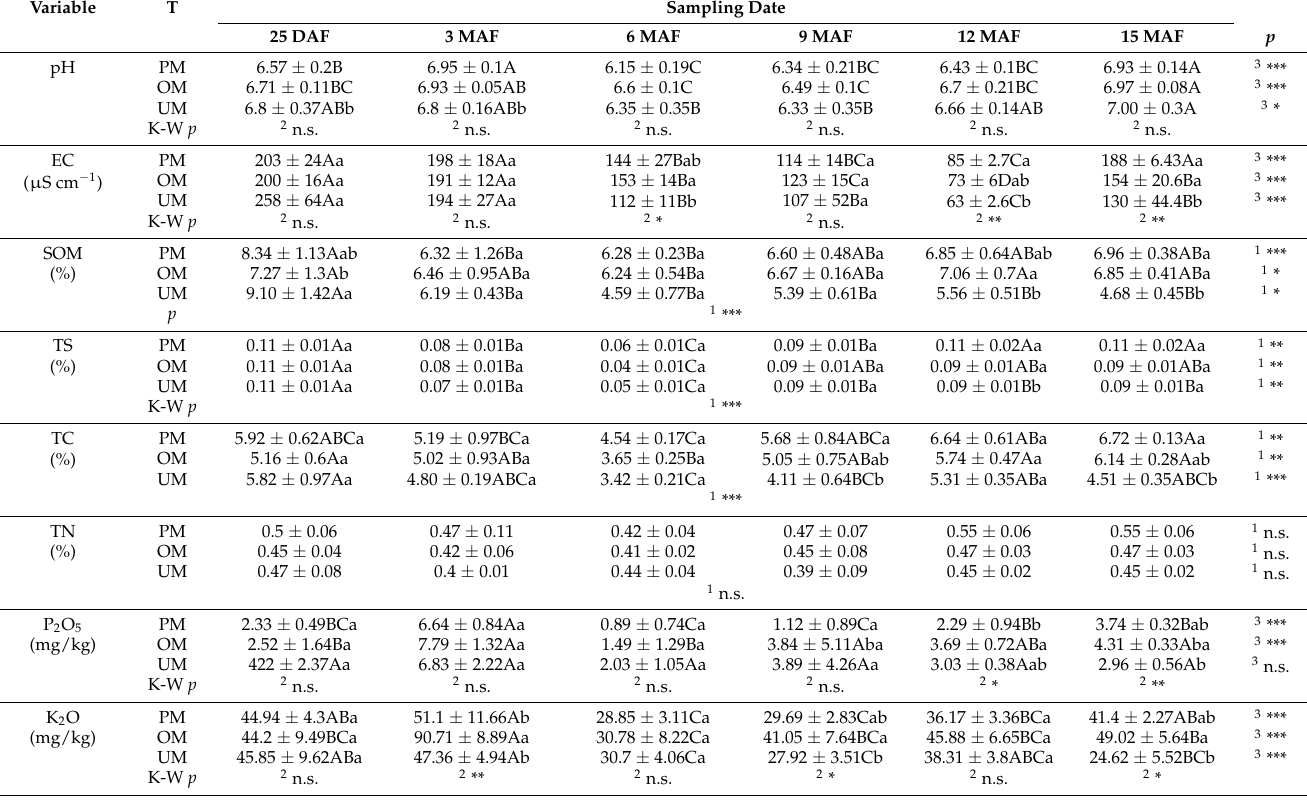
Table 4. Soil pH, electrical conductivity (EC), soil organic matter (SOM), total sulphur (TS), total nitrogen (TN), total carbon (TC), and concentrations of P 2 O 5 and K 2 O in the pine mulch (PM), olive mulch (OM), and unmulched (UM) treatments (T) during the studied period (T, treatments; DAF, days after fire; MAF, months after fire) (mean ± standard deviation). Different letters indicate significant differences between sampling dates (capital letters) and treatment (lowercase letters). 1 Two-way ANOVAs are shown for each treatment–sampling date comparison. 2 Kruskal–Wallis (K-W) tests (* p < 0.05, ** p < 0.01, *** p < 0.001, and n.s. non-significant at p < 0.05) are shown for each comparison between treatments, and 3 Friedman ANOVA between sampling dates.